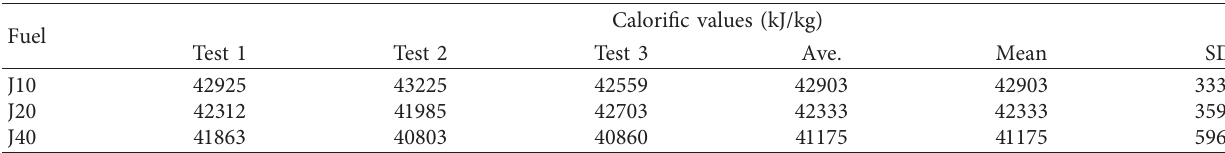
Table 5: Calorific values of blended fuels.